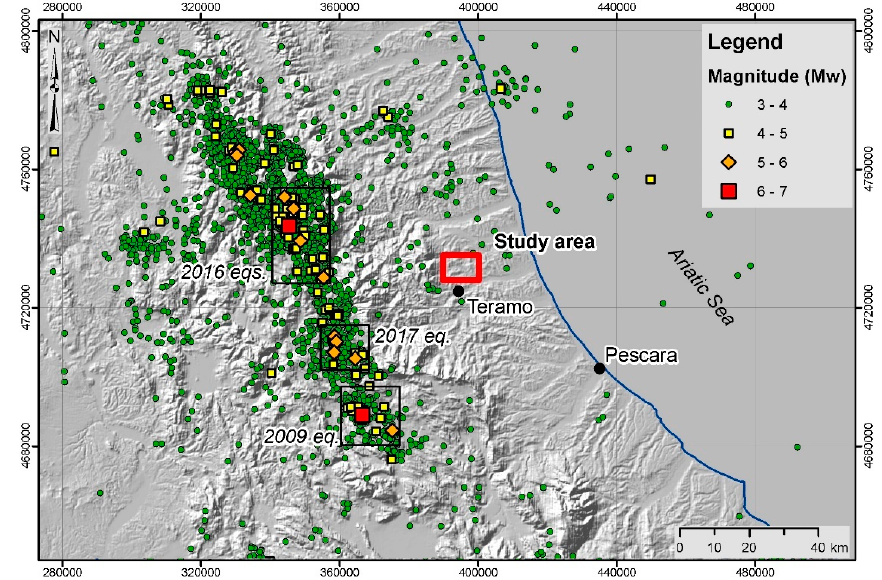
Figure 4. Recent seismicity of the Central Italy area and affecting the Apennines piedmont hilly area of NE-Abruzzo; earthquakes (Mw > 4) occurring since 1985 (from ISIDe working group (2016) version 1.0, DOI: 10.13127/ISIDe).